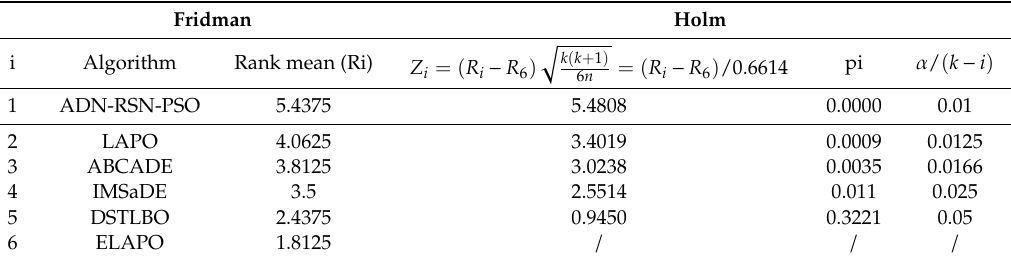
Table 4. The results of the non-parametric